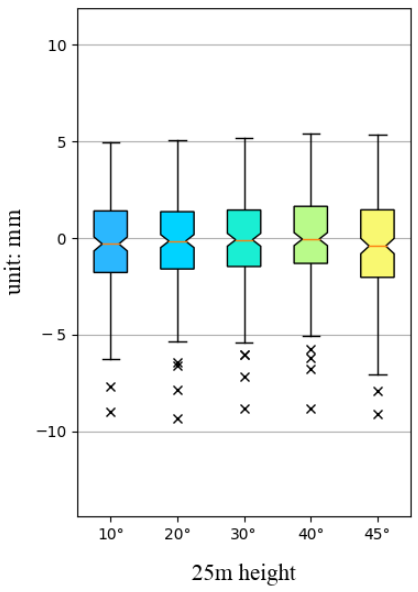
Figure 8. Distribution of measurement errors at different oblique angles.